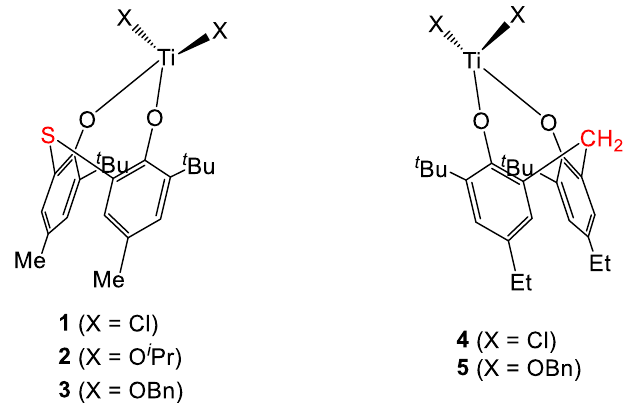
Figure 2. Titanium complexes bearing sulfur- and methylene-bridged diphenolates [6,7].